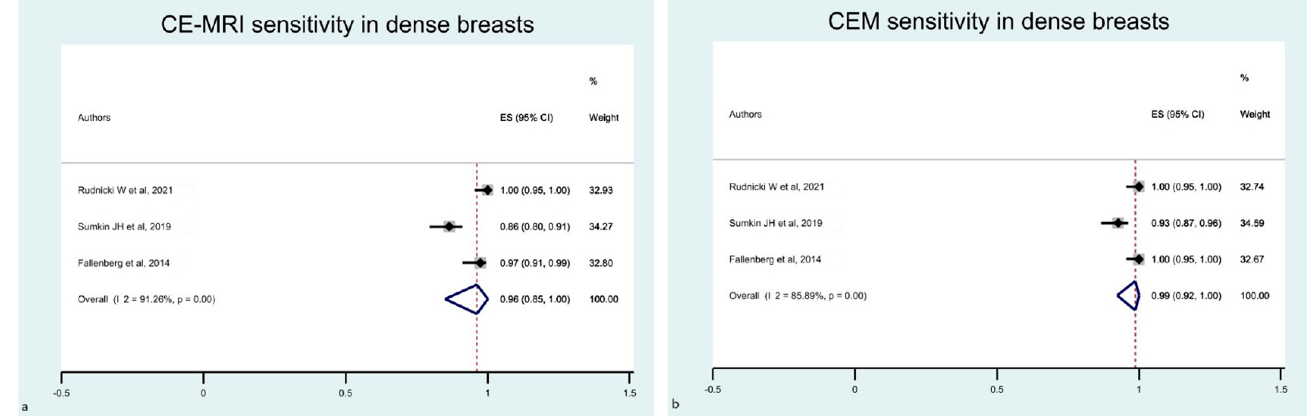
Figure 10. Forest plot of the estimated pooled sensitivity of breast CE-MRI ( a ) and CME ( b ) in the detection of pathological breast lesions in women with dense breasts. The estimated pooled sensitivity of CE-MRI was 0.98 (95% CI 0.91 – 1.00; I 2 = 78.96% p = 0.001). The estimated pooled sensitivity of CEM was 0.99 (95% CI 0.92 – 1.00;I 2 = 85.89% p = 0.001) [16,22,33].